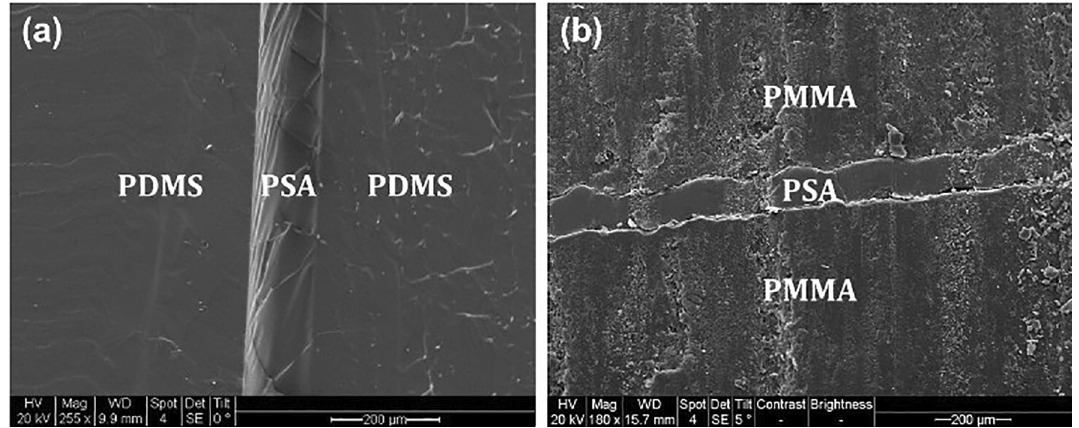
Figure 3. Cross-sectional scanning electron microscopy images of the ( a ) PDMS–PSA–PDMS construct where PSA is plasma bonded to PDMS and ( b )